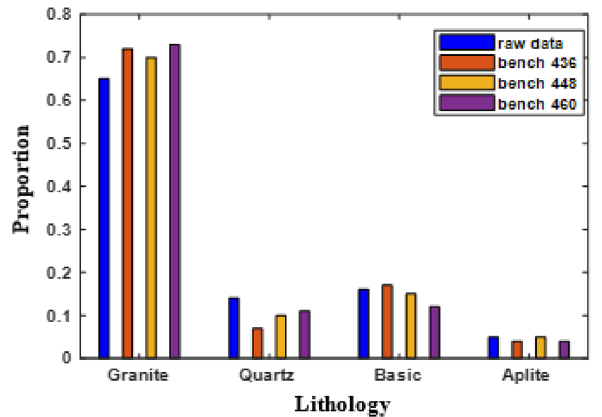
Figure 4. Information on the lithotype proportion computed using raw core and composite samples separately in three consecutive benches: 436 m, 448 m, and 460